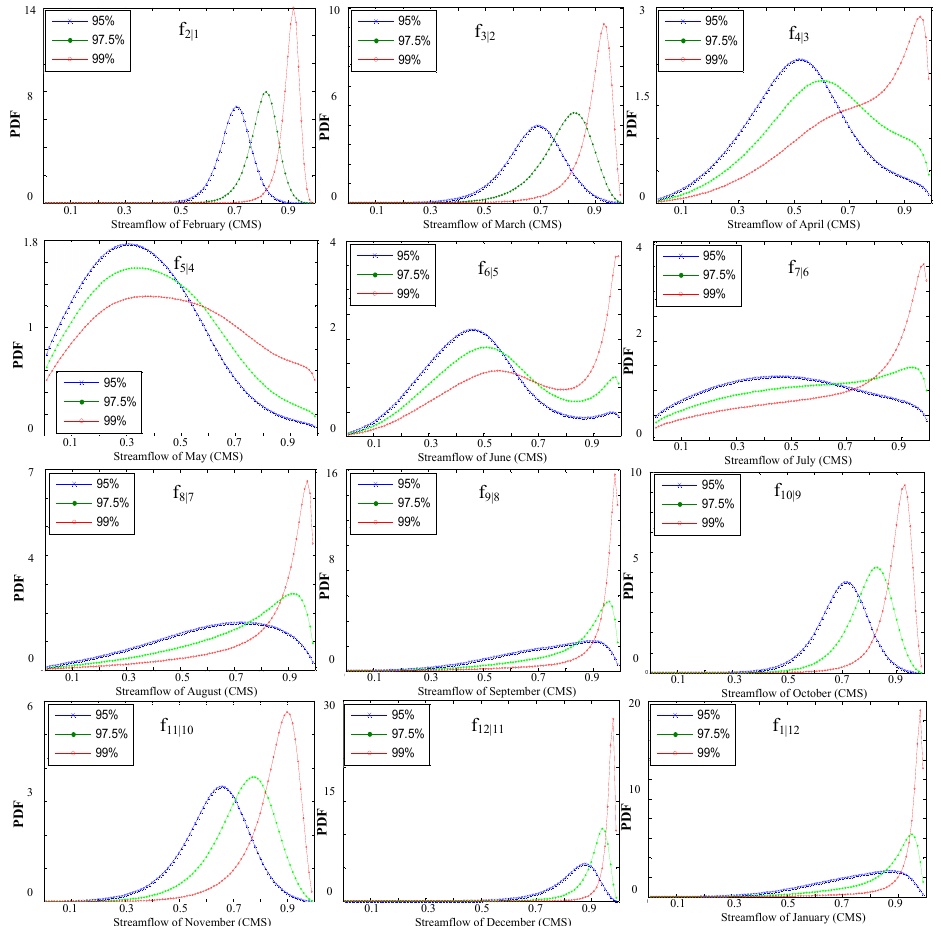
Figure 5. Distribution of streamflow in each month given the streamflow status (0.95, 0.975, 0.99) in the previous month. The values are calculated monthly from 1957 to 2009. The abscissa represents streamflow values, which are scaled into [0,1]. f K+1|K indicates the conditional PDF of two adjacent monthly streamflows, K and K+1. 0.95, 0.975 and 0.99 mean the steamflow status of K’s streamflow.